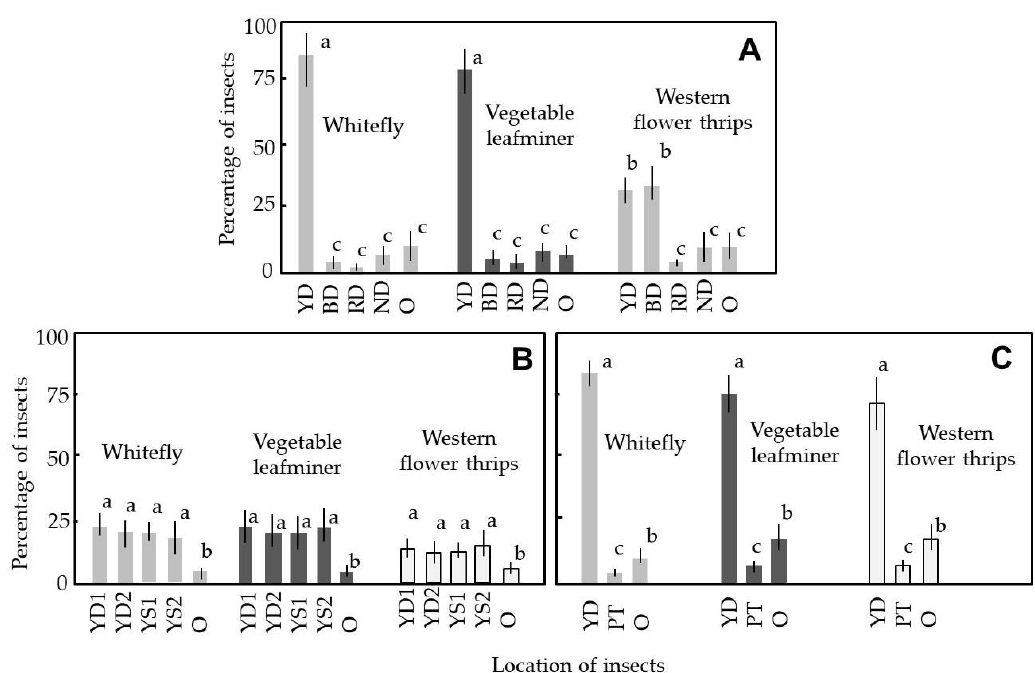
Figure 7. ( A ) Comparative assay of insects’ photoselective responses to three colored double-charged dipolar electric field producers (DD-EFPs) and a non-colored DD-EFP. Four DD-EFPs were placed in the closed box and along four faces of the box; an open vial containing test insects was placed at the center of the box. ( B ) Comparison of attraction of test insects between yellow-colored DD-EFPs and sticky traps. Two DD-EFPs and sticky traps were placed along four faces of the box; an insect-containing vial was placed at the center of the box. ( C ) Assay of preferential attraction of test insects by a yellow-colored DD-EFP placed in front of a potted tomato plant. A potted plant and insect vial were placed on opposite sides of the box, respectively; the DD-EFP was placed in front of the plant. Adult insects (whiteflies, vegetable leafminers, western flower thrips) were used as test insects. In all experiments, destinations of test insects were recorded 2 h after their release. YD, BD, RD, and ND represent yellow-, blue-, red-, and non-colored DD-EFPs, respectively; O represents other places, such as in the vial or on the floor, wall, and ceiling of the box. YD1 and YD2, and YS1 and YS2, correspond to two yellow-colored DD-EFPs and yellow sticky traps, respectively; PT indicates a potted tomato plant. Twenty insects of each species were used in each experiment; the means and standard deviations were calculated from five replicates of the experiments. The letters (a–c) in each vertical column indicate significant differences ( p < 0.05) according to Tukey’s test.